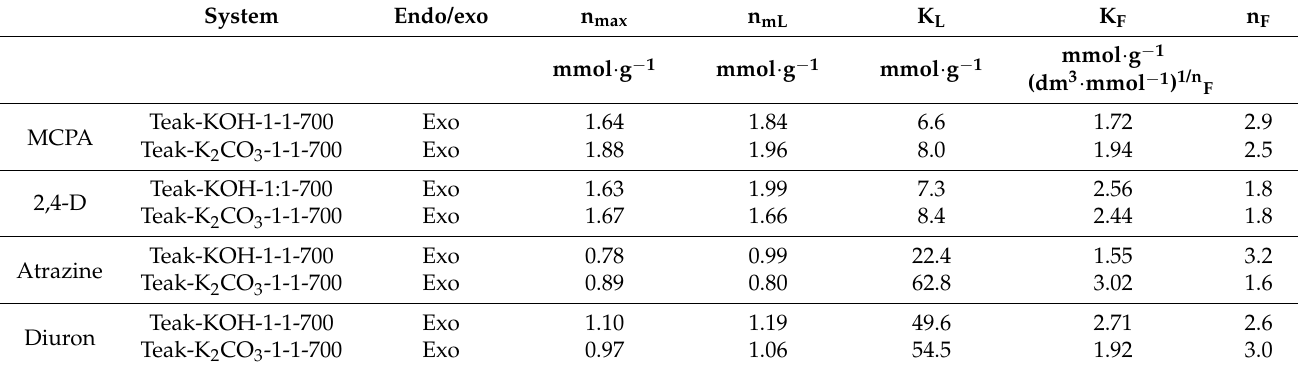
Table 4. Adsorption isotherm parameters of MCPA, 2,4-D, atrazine and diuron onto